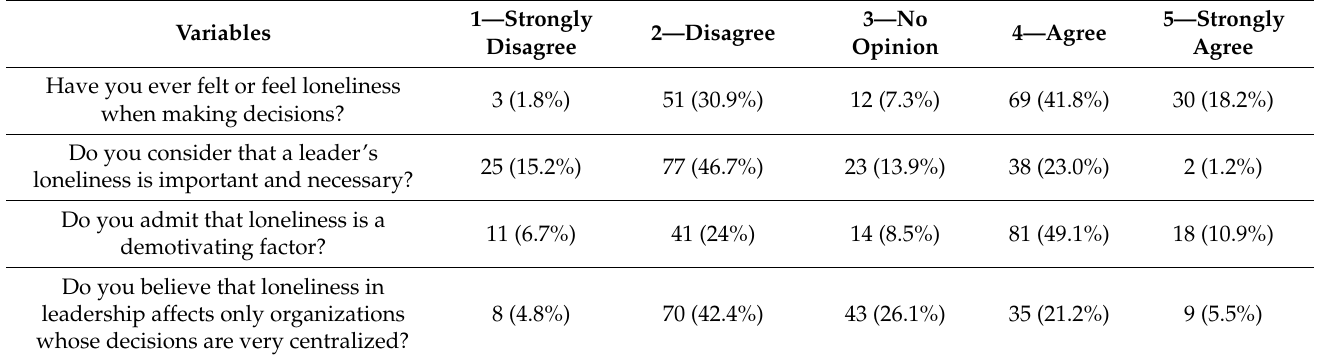
Table 7. Sample characterization regarding the loneliness in